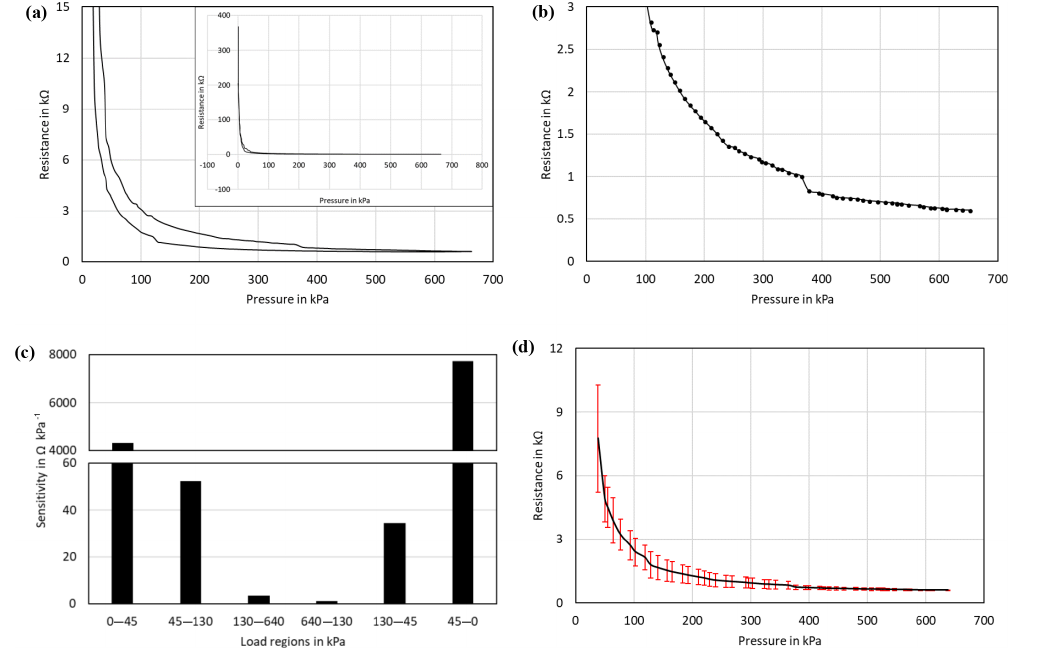
Figure 4. (a) Piezoresistive response of the sensor under applied load in nominal operation range and complete operation range (inner figure). (b) Response with reduced sensitivity at higher loading conditions. (c) Sensitivity scale in different loading regions of the sensor. (d) Hysteresis of the sensor during the loading–unloading